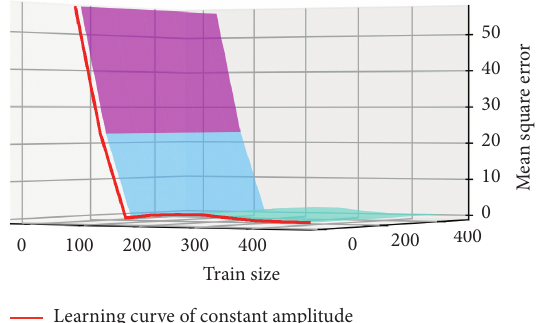
Figure 17: Prediction of crack length with variable amplitude by SVR.